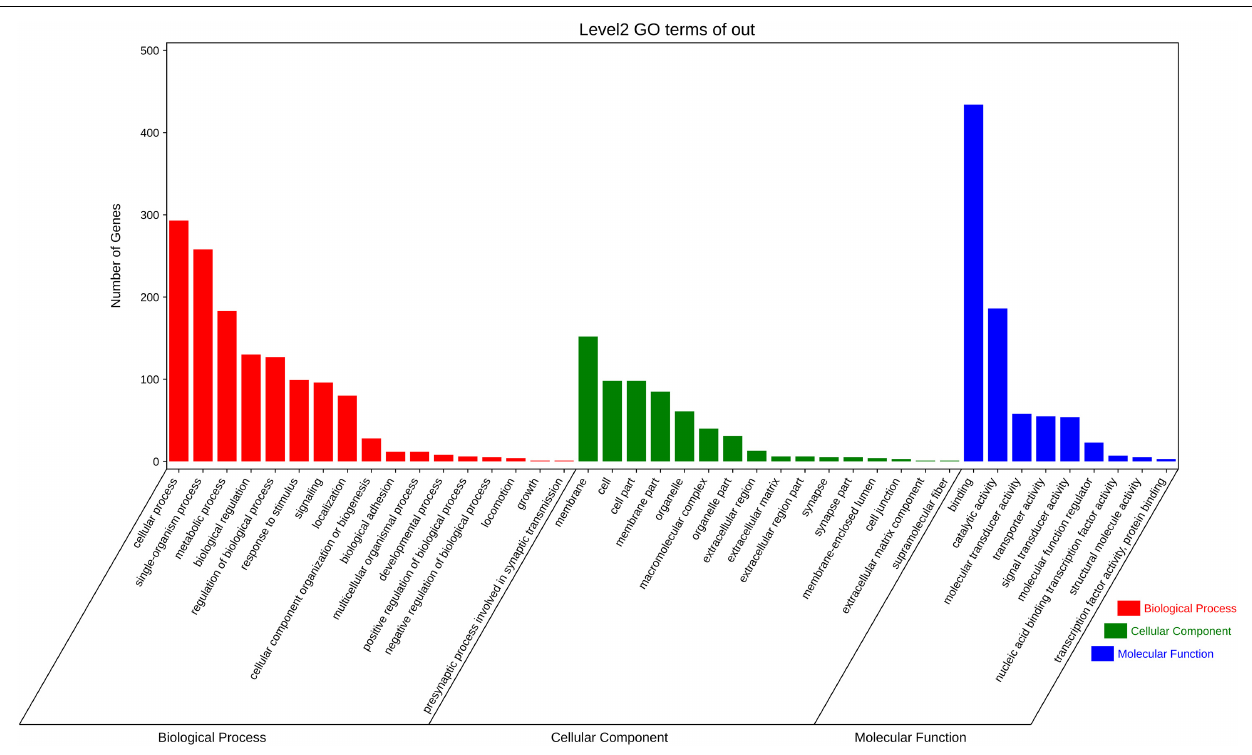
Frontiers in Genetics |